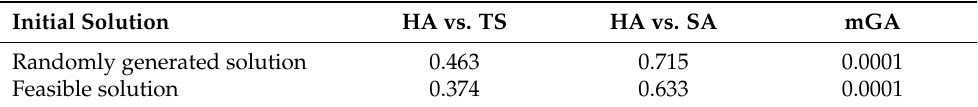
Table 8. p -values for the comparison of the minimum startup time of the metaheuristic Hybrid Algorithm (HA) vs. Tabu Search (TS), Simmulated Annealing (SA) and the micro Genetic Algor- tihm